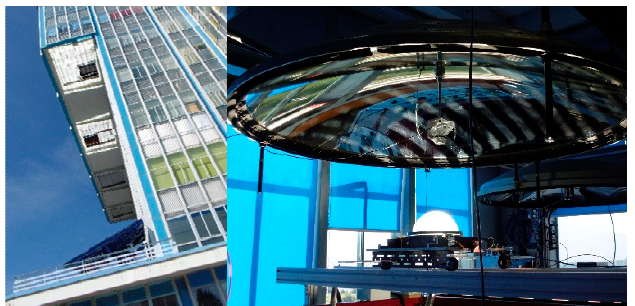
Figure 1. Experimental equipment used in the experiments. Parabolic concentrator and experimental device ( right ) and heliostat ( left ).